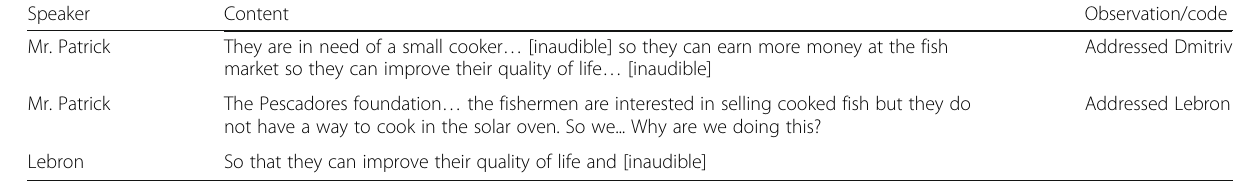
Table 4 Conversation between Mr. Patrick, Lebron, and Dmitriv during the last day of the unit in lesson 12